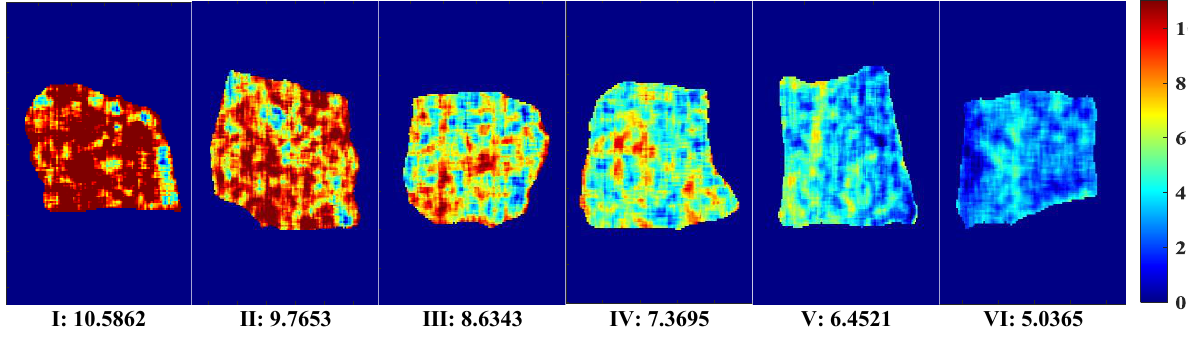
Figure 7. Visual distribution of Ala content.